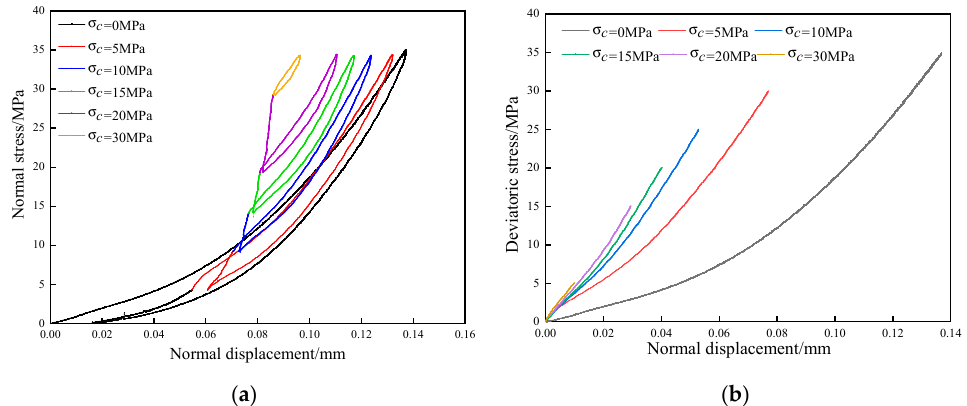
Figure 8. Normal loading and unloading stress versus normal displacement curves of rock fractures under different lateral stresses: ( a ) Whole process curves; ( b ) Amplified loading process curves.